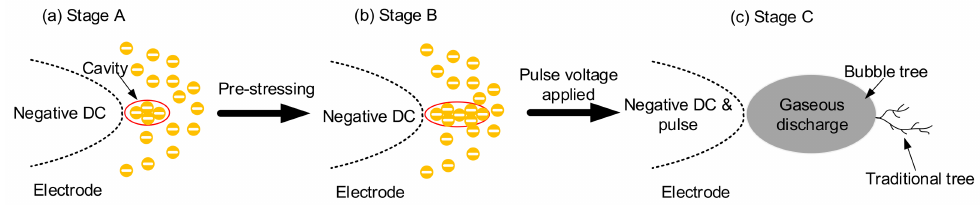
Figure 11. Bubble tree inception with prestressing DC: ( a – c ) stages A, B and C of bubble tree inception,